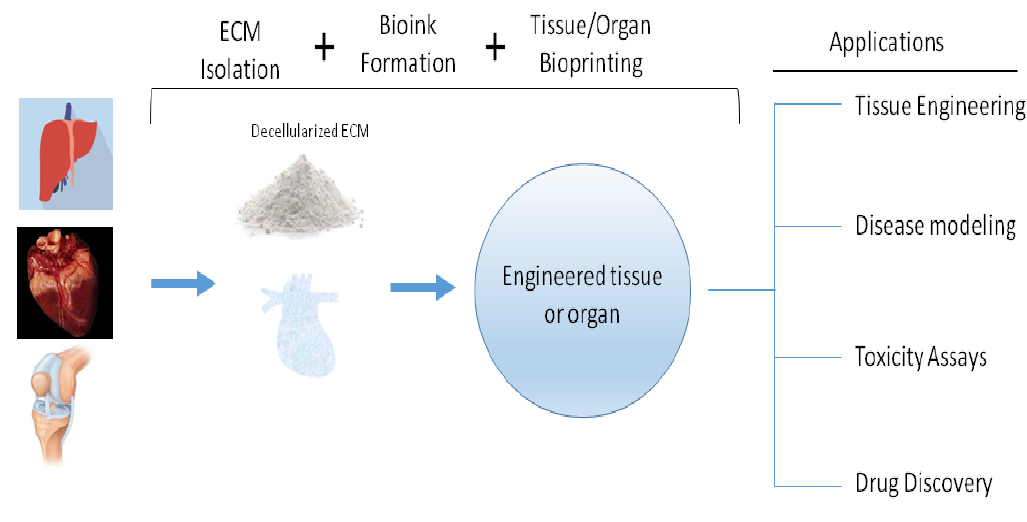
Figure 4. Decellularized ECM can be obtained from tissues or organs. Bioprinting produce engineered tissues or organs that can be used in several applications such as tissue engineering, disease modeling, and drug discovery.